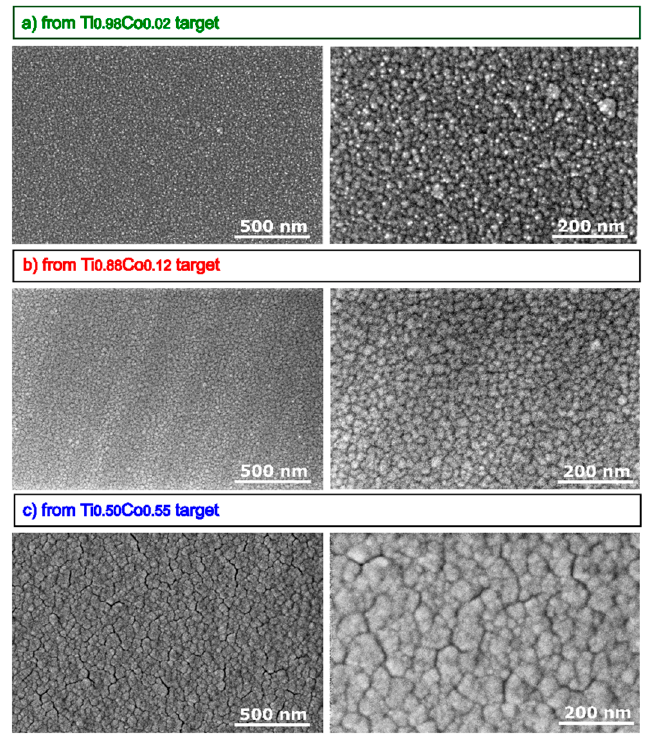
Figure 8. SEM images of surface of (Ti,Co)Ox thin films prepared from: ( a ) Ti 0.98 Co 0.02 , ( b ) Ti 0.88 Co 0.12 , ( c ) Ti 0.50 Co 0.50 targets.